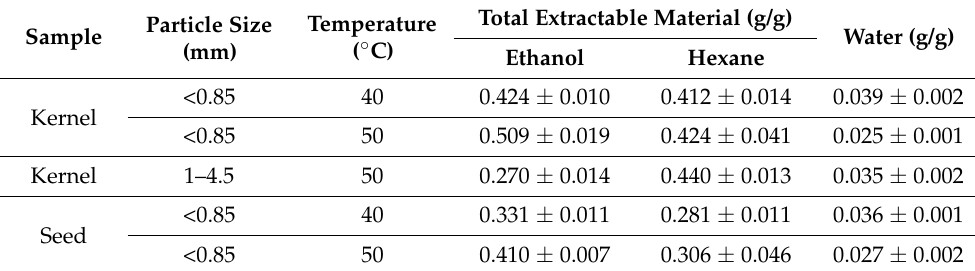
Table 1. Characterization of Moringa seeds.